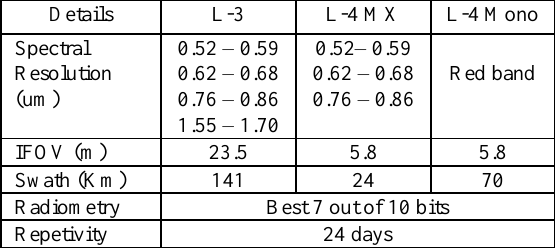
Table-1: Specifications of Resourcesat-1 sensors